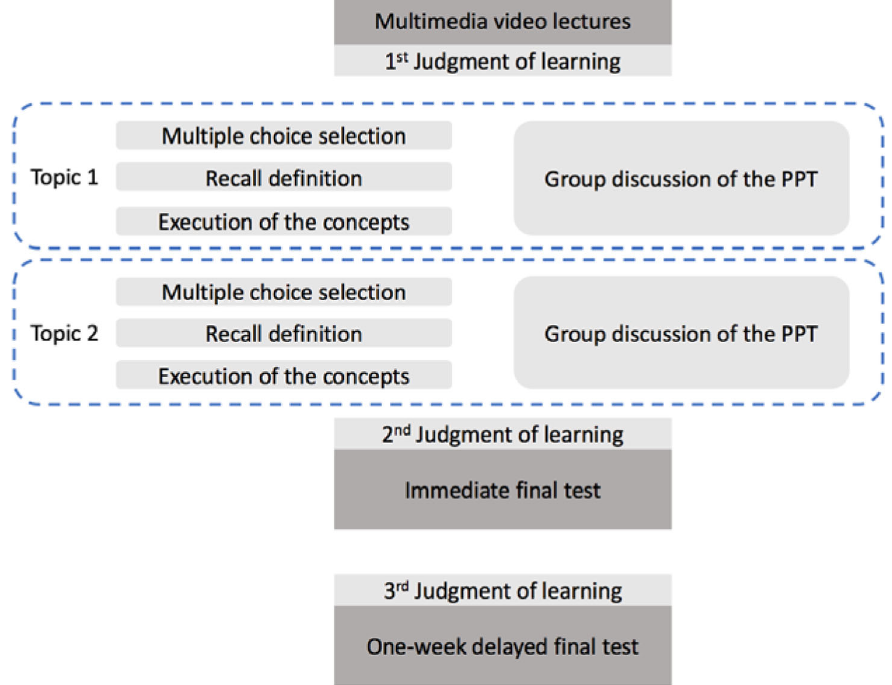
FIG. 1. Procedure of this study, from top to